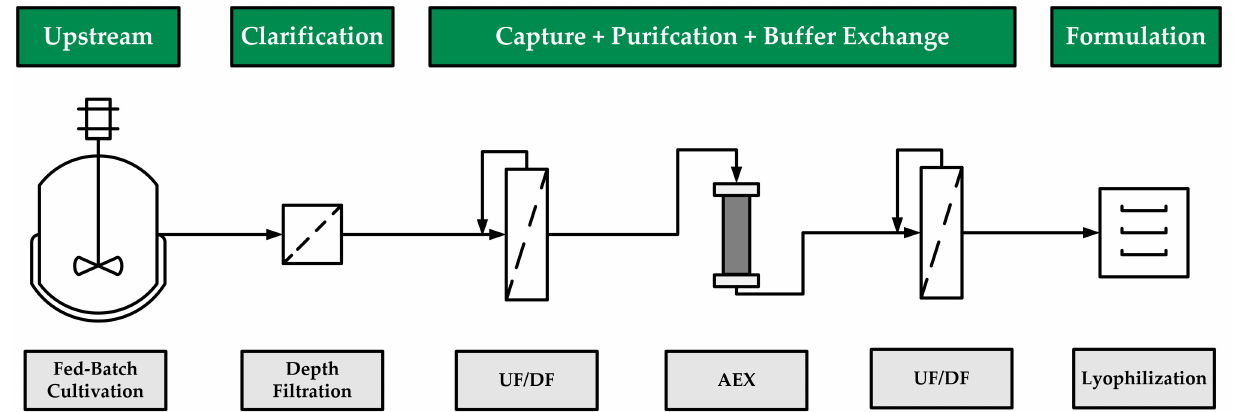
Figure 3. Process flow diagram showing the production and subsequent three-step purification of HIV-gag VLPs. Capture is achieved by depth filtration, ultrafiltration/diafiltration (UF/DF) is used for concentration and initial purification, anion exchange chromatography is used for further purification and concentration, and lyophilization is used for the formulation of HIV-gag